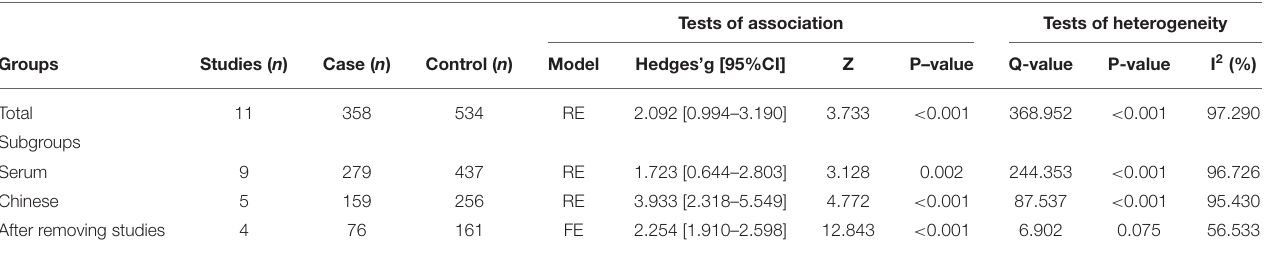
TABLE 2 | Summary of meta-analysis